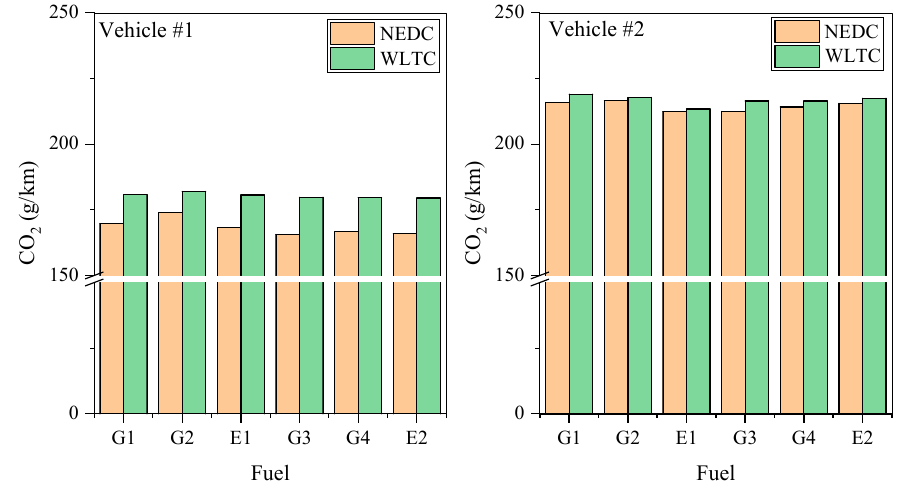
Figure 2. Specific CO 2 for the six fuels.